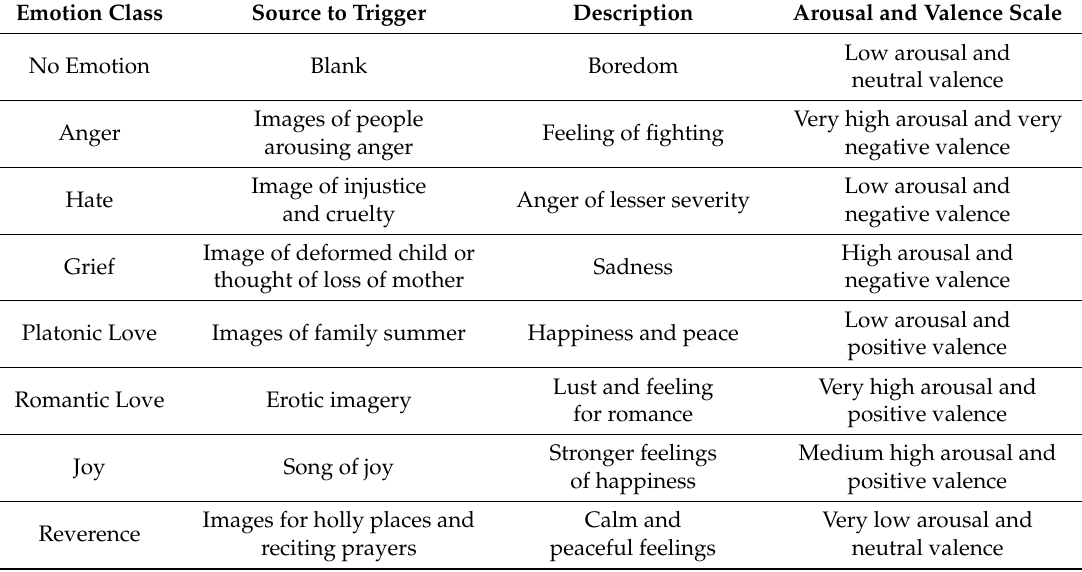
Table 5. Description of the eight emotional states